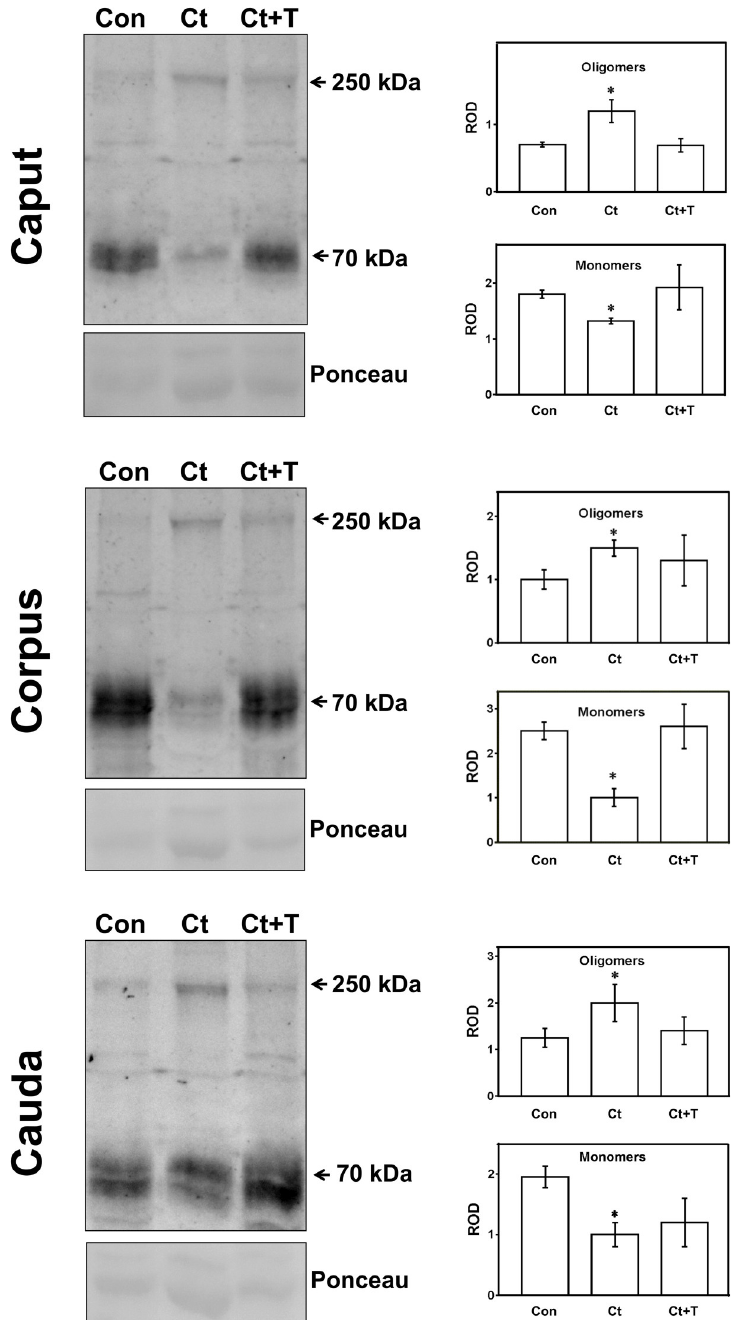
Fig 10. Detection of oligomeric forms of prosaposin in epididymal fluid from control (Con), castrated (Ct) and castrated with testosterone supplementation (Ct+T) animals. Proteins from epididymal fluid were run on SDS-gel under non-reducing conditions and electrotransferred onto nitrocellulose membrane for detection with the specific antibody. Monomers (70 kDa) and oligomers (250 kDa) of PSAP were detected. The figure shows representative immunoblots from each epididymal region and the corresponding quantification of the bands, as indicated. Bars represent the means of relative optical density (ROD) ± SE from three independent experiments. ( � ) significant differences from the control (p < 0.05, obtained by Tukey’s Multiple Comparisons Test). Ponceau staining was used as loading control.